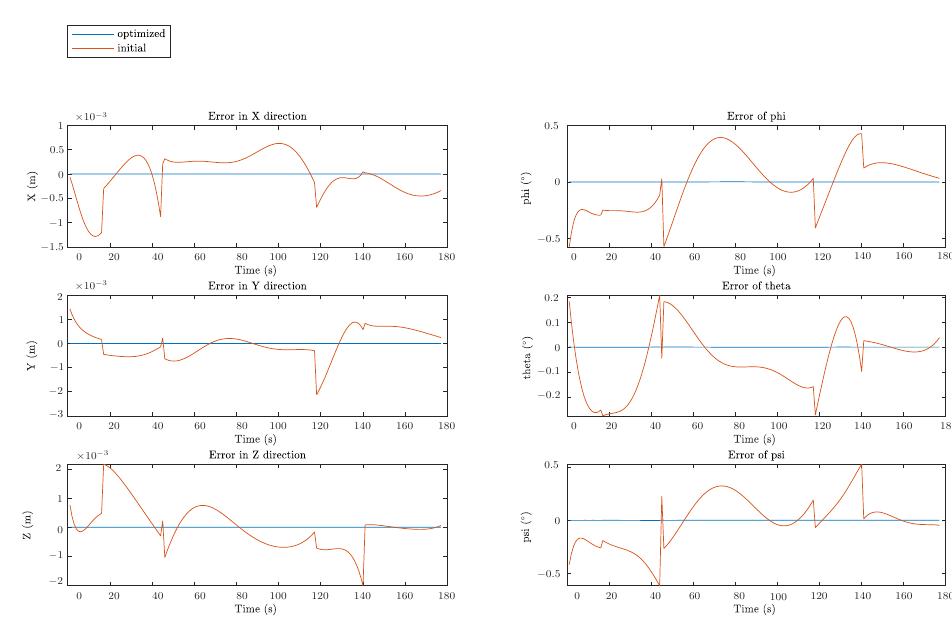
Figure 10. Errors for translation and rotation in each direction.